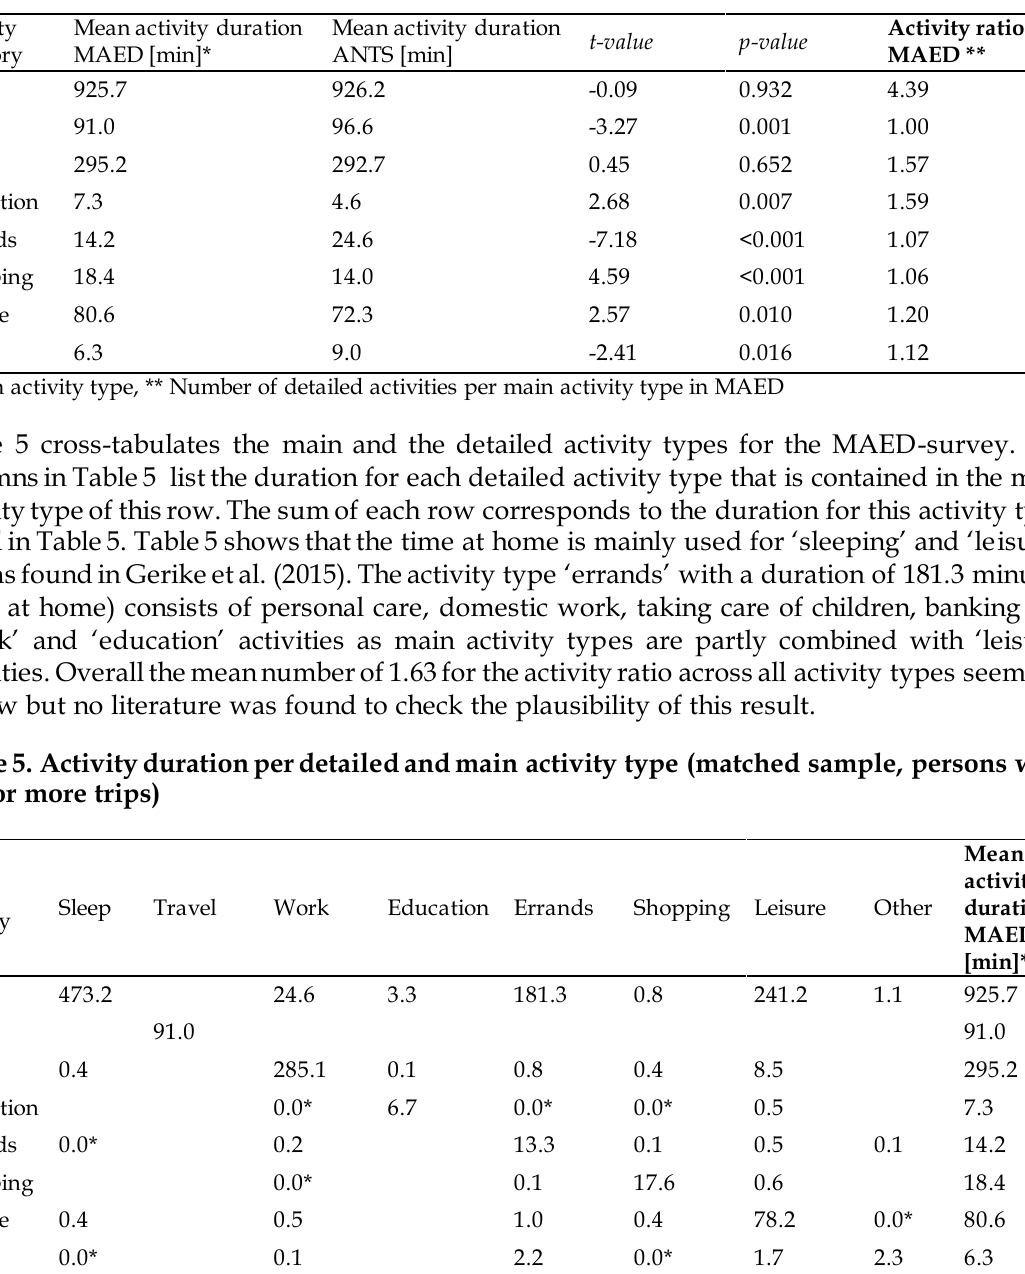
Table 4. Activity duration in the MAED-survey and the ANTS (matched sample, persons with two or more trips)